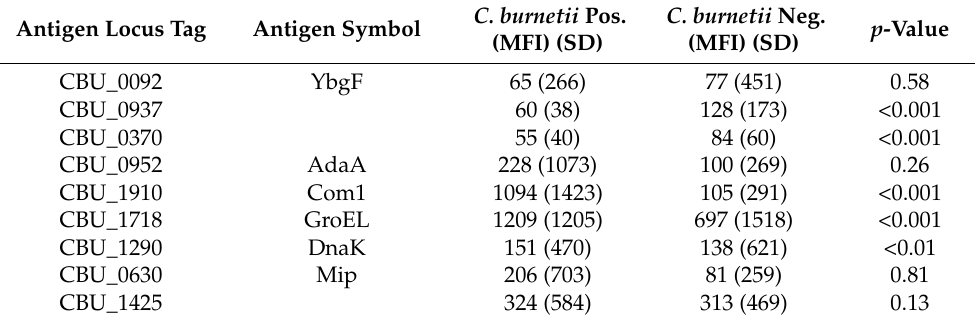
Table 2. Quantitative seroresponses to nine selected C. burnetii antigens measured with multiplex serology in a serum dilution of 1:100. Reference samples were grouped according to a positive (pos.) or negative (neg.) C. burnetii reference assay test result. Groups were compared using Mann–Whitney U test. A p -value below 0.05 was considered statistically